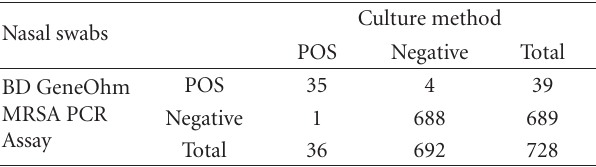
Table 1: Comparison of BD GeneOhm MRSA and culture in the detection of MRSA with nasal swabs.